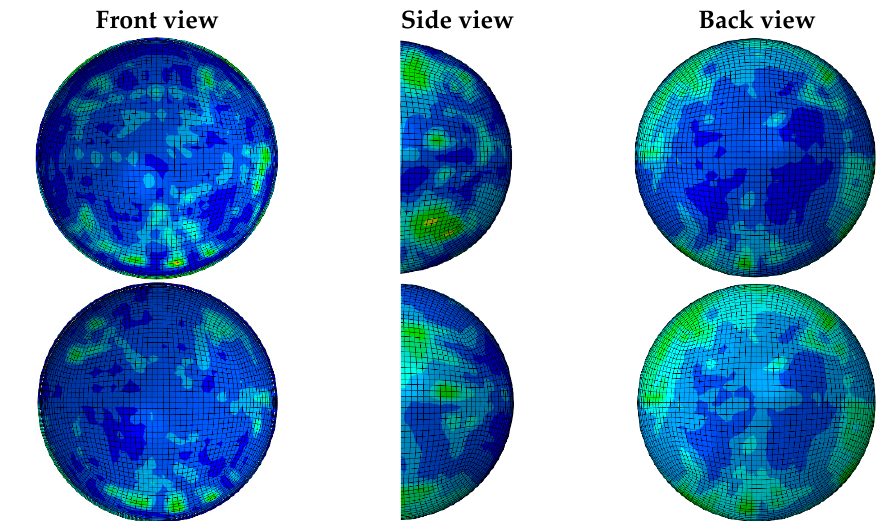
Figure 6. Comparison of FE simulated von Mises stress pattern and PLSR-predicted von Mises stress (soccer ball velocity was 65 mph and frontal impact location). General agreements can be seen in the location and magnitude of maximum stress.